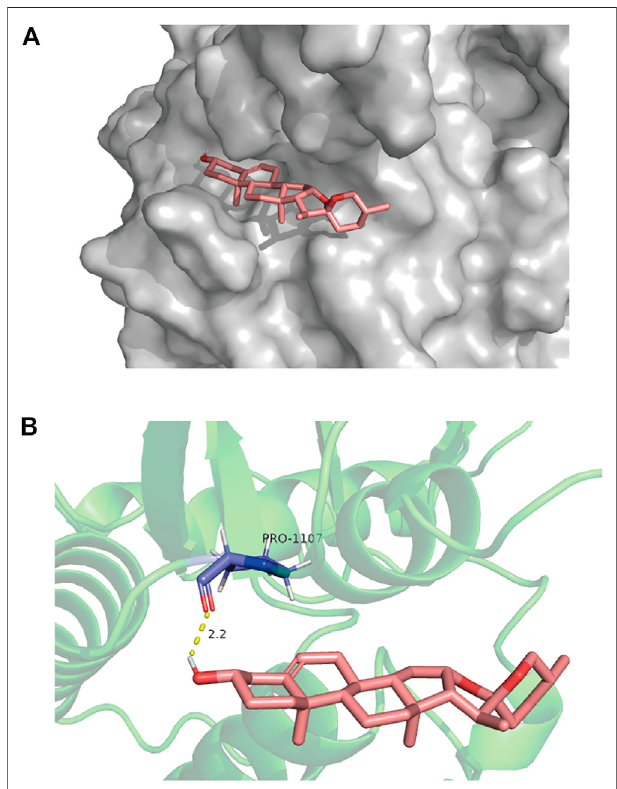
FIGURE 7 | The molecular docking of IGF-1R and diosgenin is shown. (A) The picture shows that the structure of diosgenin in 3D is located in the binding pocket of IGF-1R. The pink image on the right represents diosgenin. (B) Theproteintargetthatbindstodiosgeninisintheshapeofabluerod, and the binding sites are connected by yellow hydrogen bonds. The length of the hydrogen bonds is indicated next to the bond.